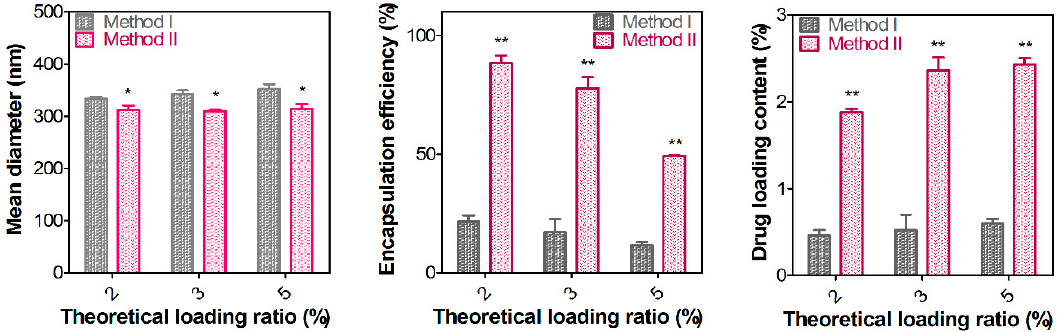
Figure 4. Particle properties of docetaxel-loaded CHS-CS NPs. Mean diameter, encapsulation e ffi ciency, and drug loading content values according to the theoretical loading ratios (2, 3, and 5%) of method I and II are plotted. Encapsulation e ffi ciency (%) = (actual amount of docetaxel in NPs / input amount of docetaxel in NPs) × 100. Drug loading content (%) = (actual amount of docetaxel in NPs / amount of docetaxel-loaded NPs) × 100. * p < 0.05, ** p < 0.01.